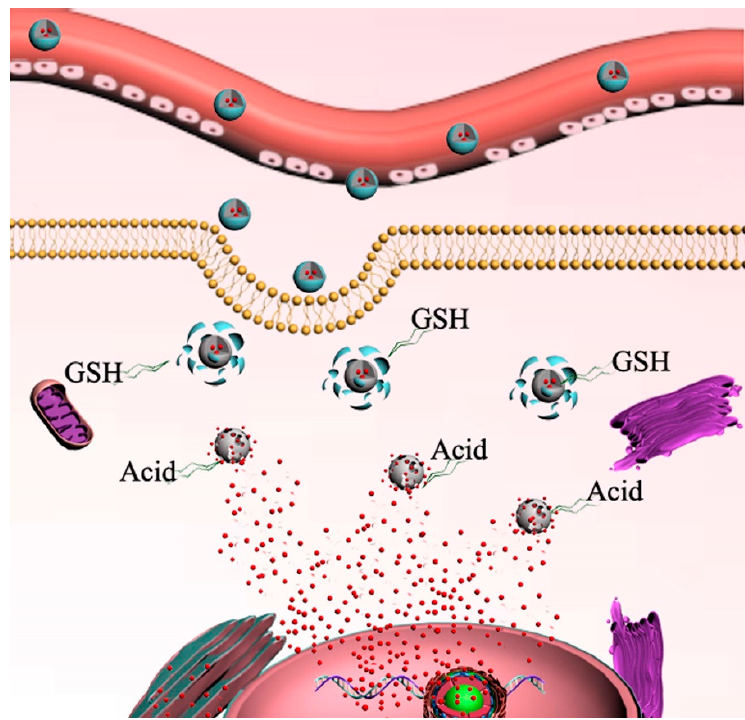
Figure 2. The illustration of DCAT nanospheres used as promising vehicles for controlled release of anticancer drug. Polyphenol coatings and calcium phosphate could be biodegraded by intracellular glutathione and acidic microenvironment, respectively, resulting the release of encapsulated drug.